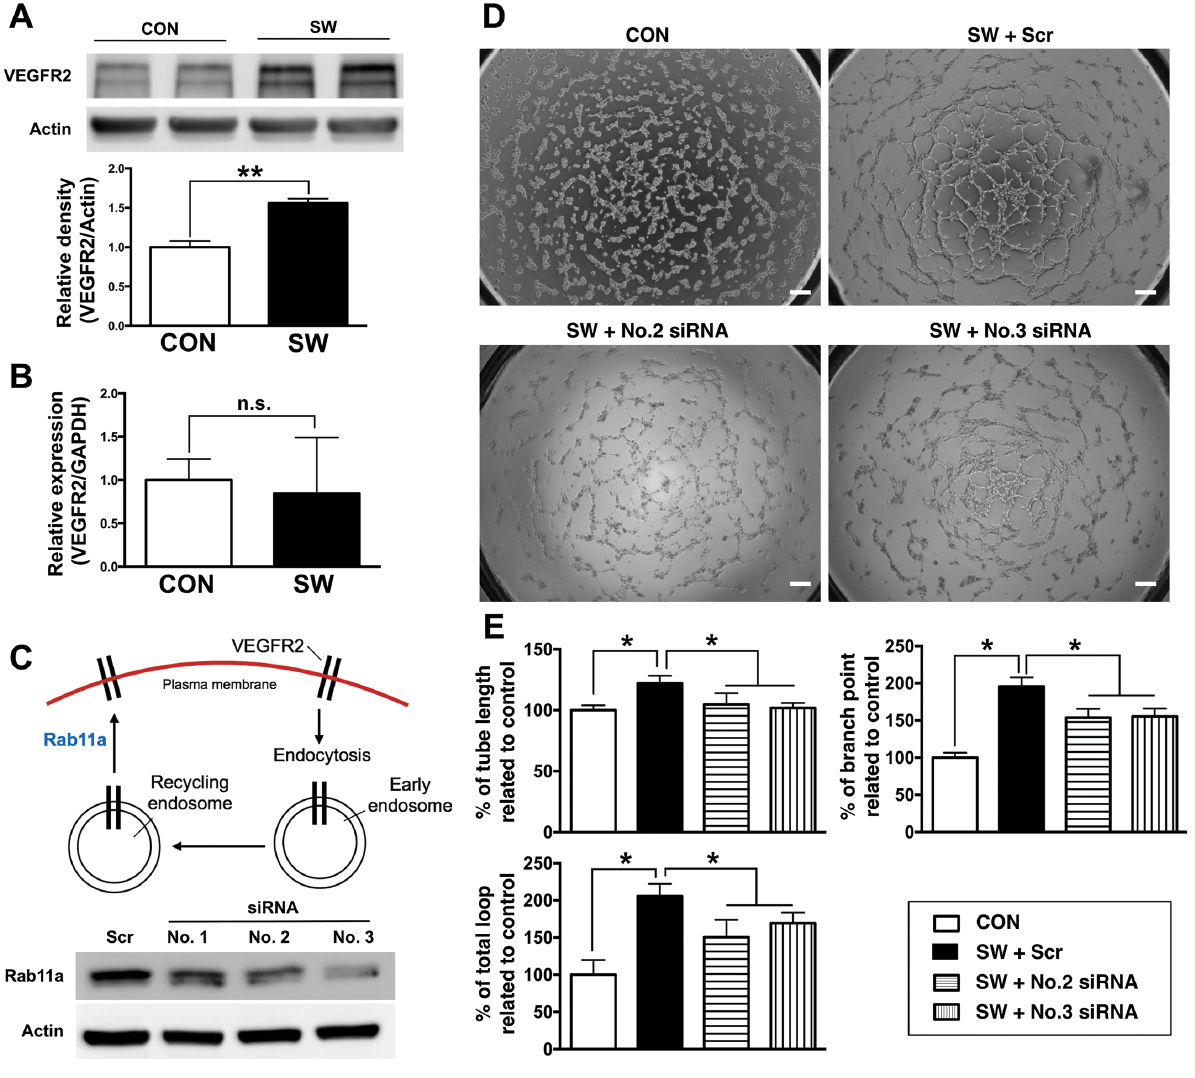
Figure 7. Expression of vascular endothelial growth factor receptor 2 (VEGFR2) in shock wave (SW)-induced angiogenesis. (A) Protein expression of VEGFR2 in HUVECs with (SW) and without (CON) SW treatment determined by Western blot (n = 4 in each group). (B) Expression of VEGFR2 mRNA in HUVECs at the end of 28 h without (CON) and with SW treatment determined by RT-qPCR (n = 3 in each group). (C) Illustration showed the endocytic route of endothelial VEGFR2 from early endosome to recycling en- dosome and ship back to the plasma membrane through Rab11a. Rab11a silencing in HUVECs by three different small interfering RNAs (siRNAs) evaluated by Western blot. (D) Tube formation assay posttransfection of scramble (Scr), No.2, and No.3 siRNAs with SW compared with those in the control (CON) without SW treatment. (E) Changes in parameters of tube formation assay, including tube length, branch point and the number of loops (n = 5 in each group) post Rab11a silencing with No.2 and No.3 siRNAs. Data shown as mean ± S.D. * P < 0.05 determined by Student t